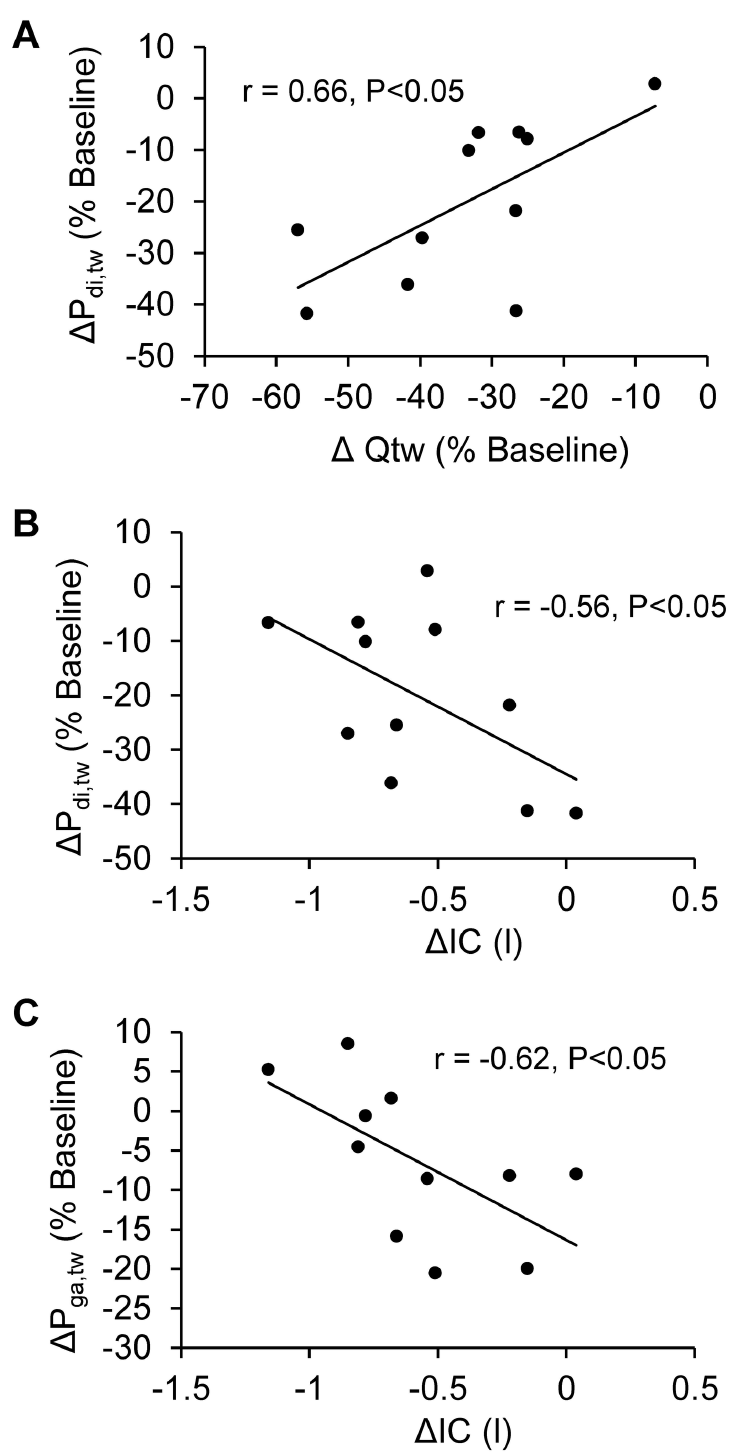
Figure 3. Correlation of the percentage reduction from baseline in transdiaphragmatic pressure evoked during cervical magnetic stimulation (ΔP ) with the percentage reduction from Baseline in quadriceps strength evoked during femoral di,tw magnetic stimulation immediately after exhaustive constant load cycling (ΔQ ; Panel A). Correlation of ΔP (Panel B) and tw di,tw the percentage reduction from Baseline of gastric pressure evoked during thoracic magnetic stimulation immediately after exhaustive constant load cycling (ΔP ; Panel C) with the reduction in IC at exhaustion (ΔIC). ga,tw doi: 10.1371/journal.pone.0083432.g003 PLOS ONE |